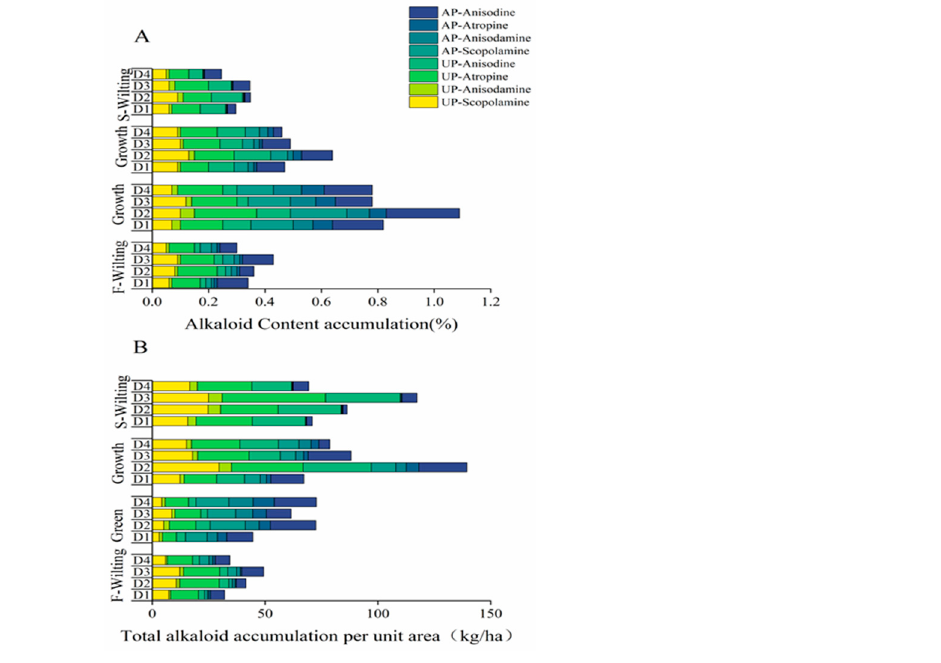
Figure 3. Accumulation of alkaloids under different density gradients. ( A ) (single plant); ( B ) (unit area).